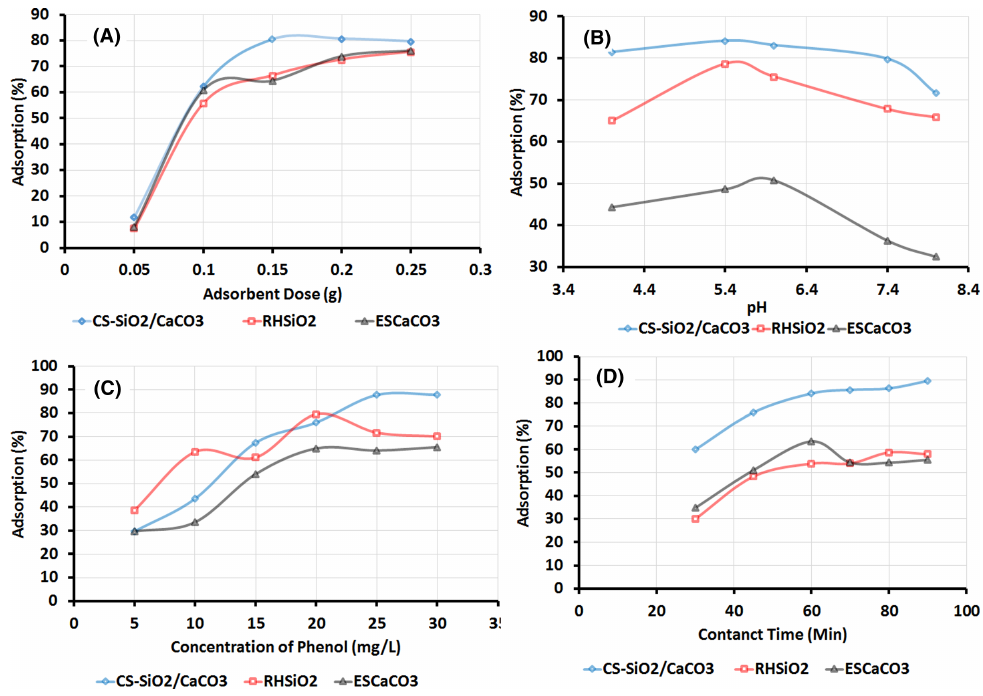
Figure 4 Effect of varying (A) adsorbent dose, (B) pH, (C) phenol concentrations, (D) contact time on the adsorption of phenol over ESCaCO 3 , RHSiO 2 and CS-SiO 2 /CaCO 3